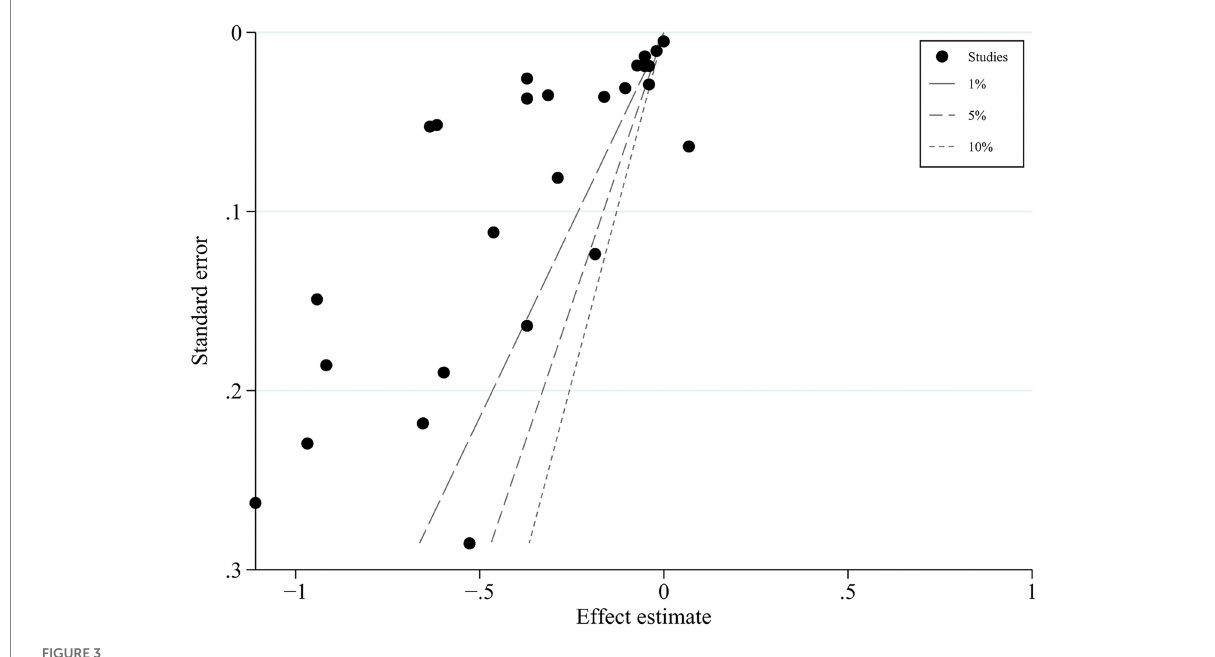
FIGURE 3 One-sided contour-enhanced funnel plot.